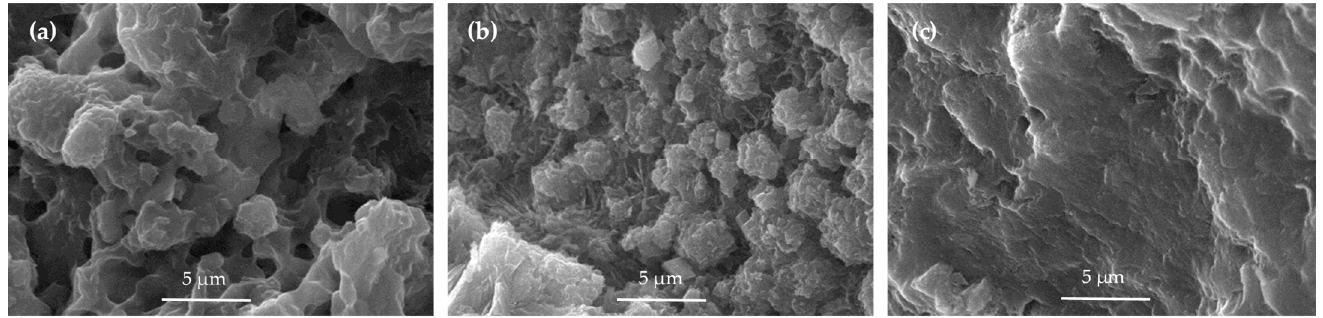
Figure 1. SEM micrographs of samples: ( a ) Ag–Zeo, ( b ) Ag–NaZeo and ( c ) Ag–HZeo.